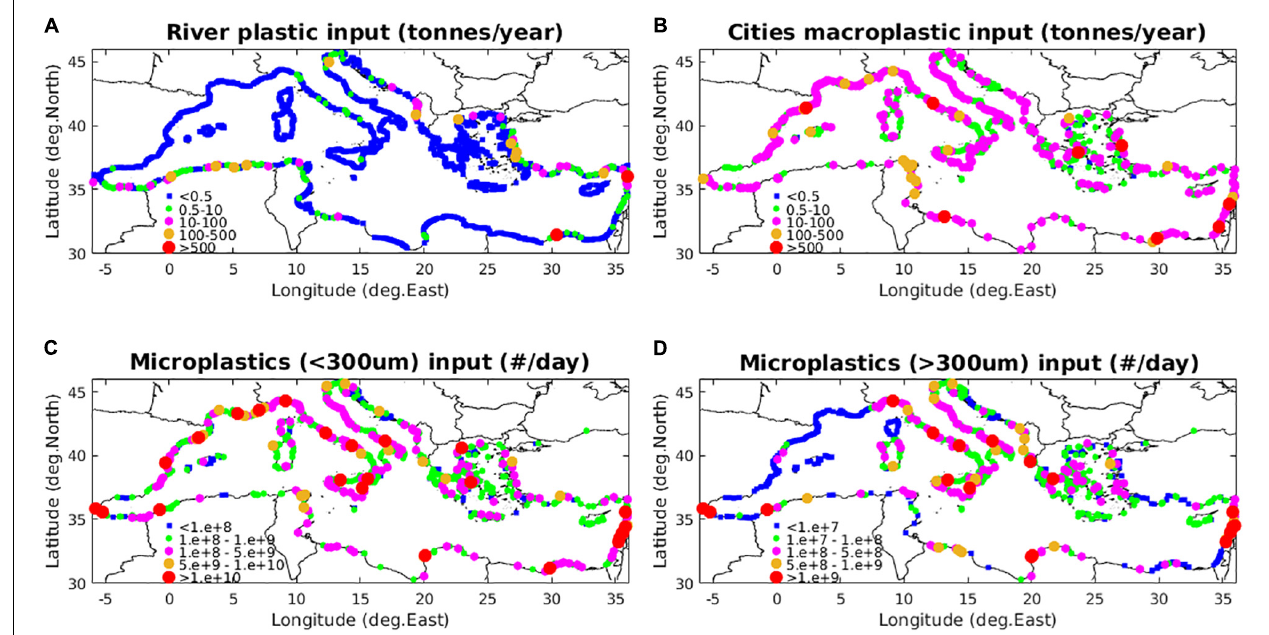
FIGURE 3 | Source inputs of (A) micro- and macroplastics with river runoff (tonnes/year), (B) macroplastics from coastal cities (tonnes/year), (C) small size microplastics ( < 300 µ m) and (D) large size microplastics ( > 300 µ m) from wastewater discharge